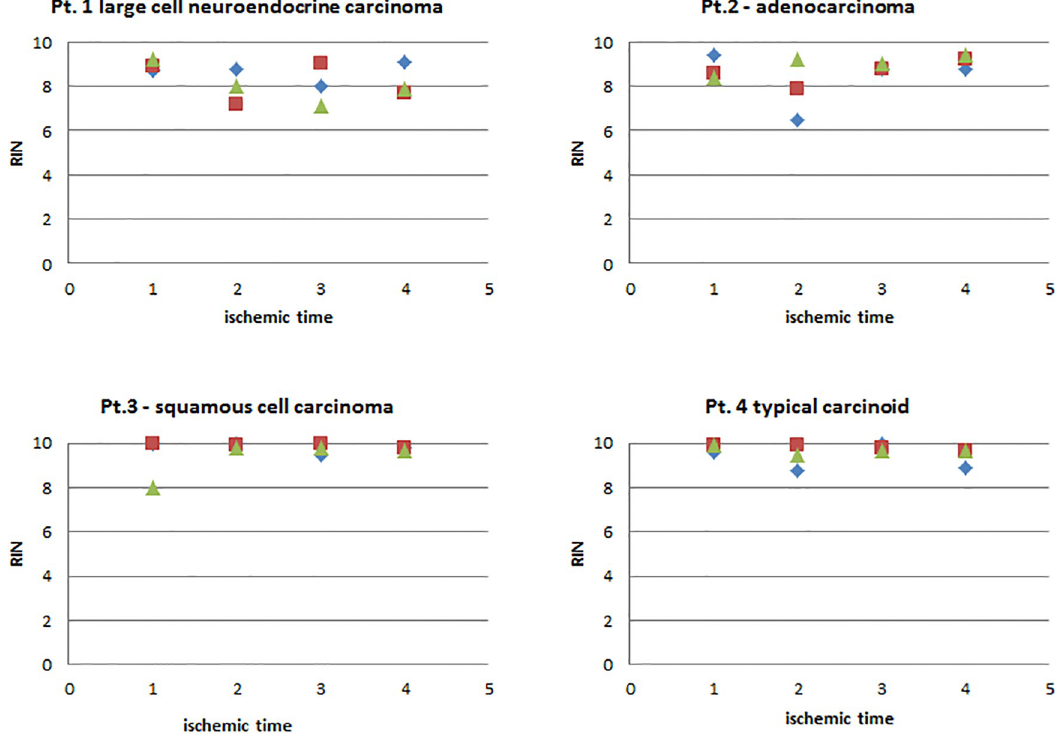
Fig 3. Influence of cold ischemic time and asservation procedure on RNA quality. Overall RNA quality isolated was assessed on an Agilent BioAnalyser. RIN (RNA integrity numbers) were compared between different ischemic times and different asservation methods (blue: shock frozen in liquid N 2 ; red: RNAlater, 1 day 4 ˚C; green: RNAlater, 7 days 4˚C); all samples were stored at -80˚C thereafter. For detailed RIN values see S1 Table.